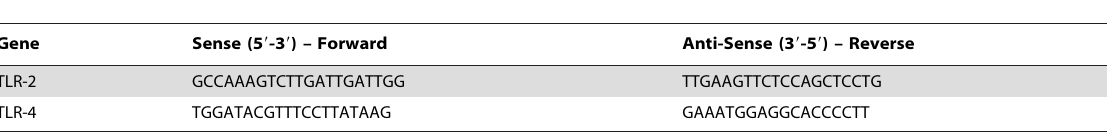
Table 1. Sequence of primers used in real-time Polymerase Chain Reaction (PCR).